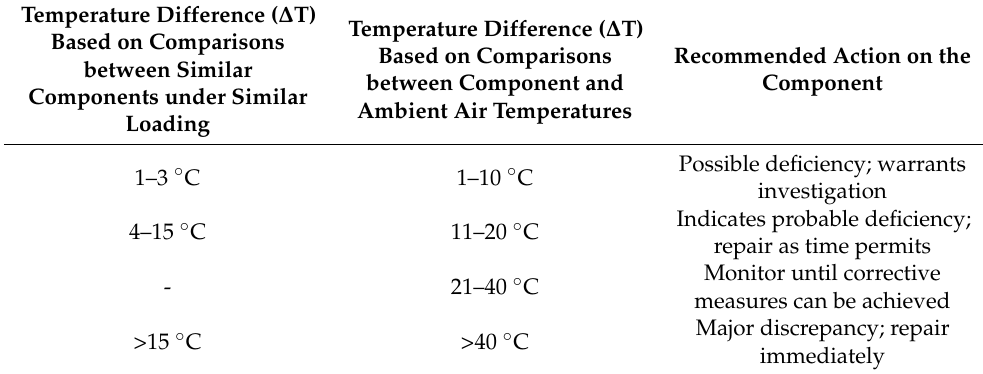
Table 1. Actions suggested by the American National Standards Institute based on the temperature